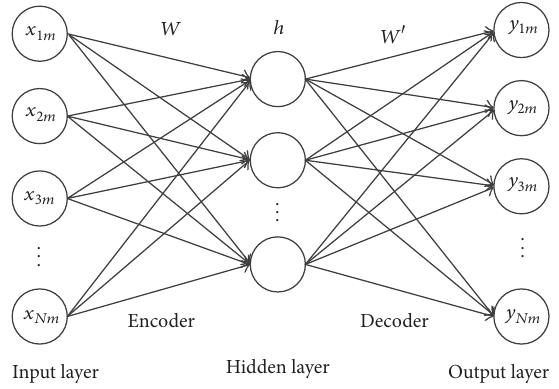
Figure 1: The model of